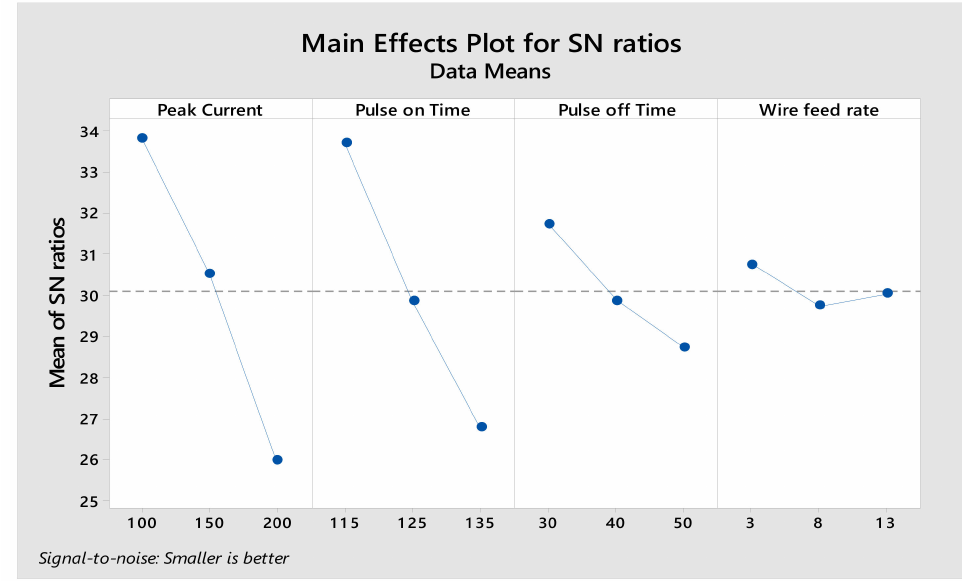
Figure 11. Main effects plot for radial